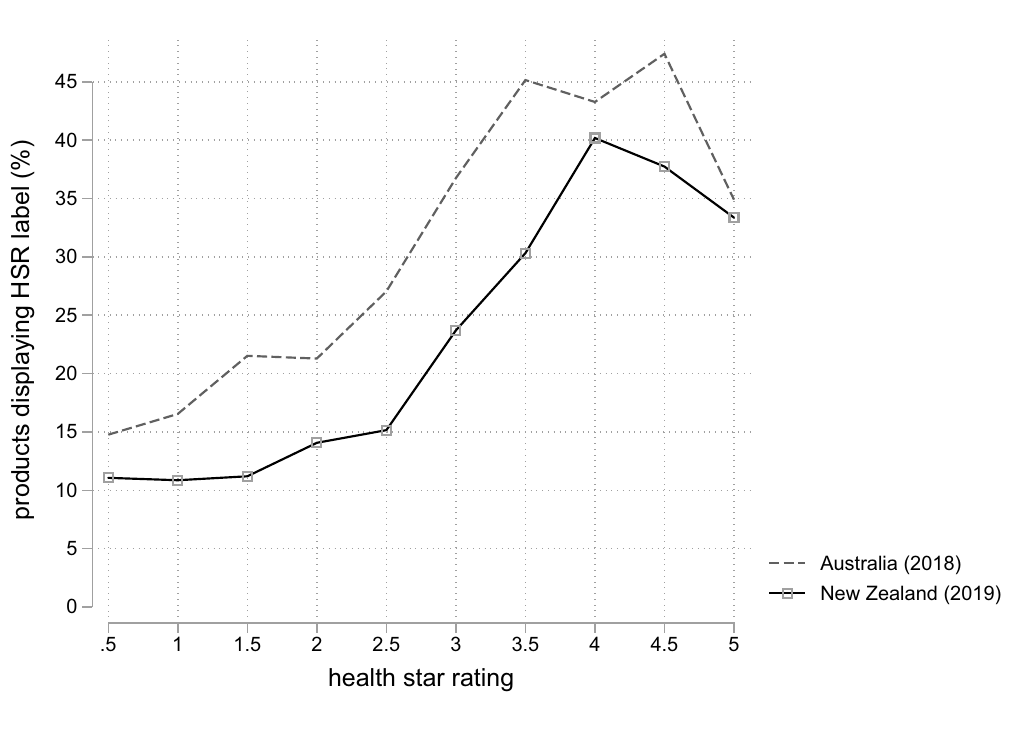
Fig 1. Percent products displaying HSR labels by imputed HSR rating for Australia in 2018 and NZ products in 2019. HSR, Health Star Rating; NZ, New Zealand. https://doi.org/10.1371/journal.pmed.1003427.g001 Of note, 17.9% of Australian products saw HSR ratings increase by � 0.5 stars, compared to 11.4% of unlabelled products, the difference between groups equalling 6.5%. NZ products saw 21.2% of HSR-labelled products increase by � 0.5 stars, compared to 10.5% of unlabelled prod- ucts, the difference between groups equalling 10.7%. Although Fig 2 did not contain data for